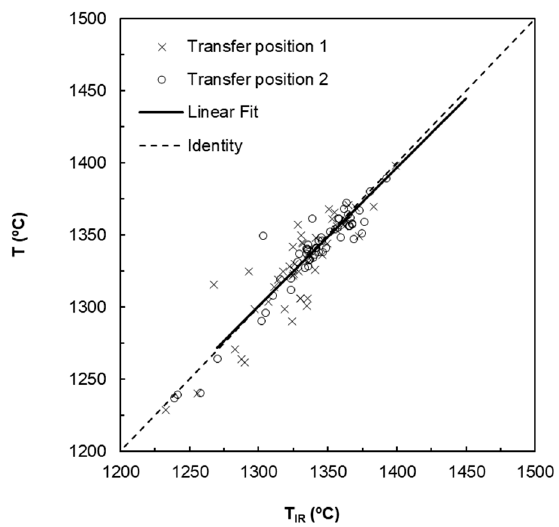
Figure 5. Comparison of the hot metal temperature obtained with an IR thermometer aimed hot metal stream T IR and with disposable thermocouples dipped in hot metal ladle after transfer T . Each dot represents a heat, and is formed by the weighted average of several hot metal discharges. The T IR values were corrected for the temperature drop that occurs during transfer from the torpedo to the ladle. Linear regression is represented with a solid line. The dashed line represents T IR = T . Elaborated from [14].